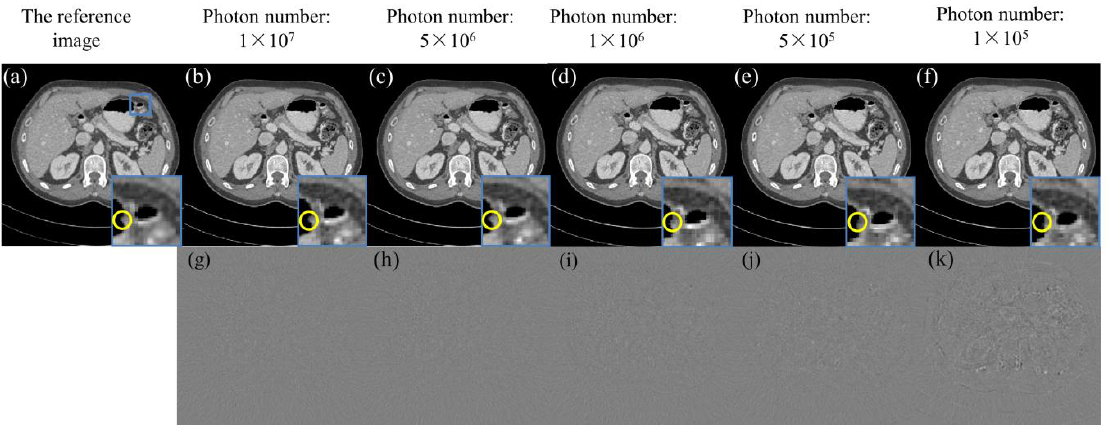
Table 3. Robustness analysis results for different noise levels.